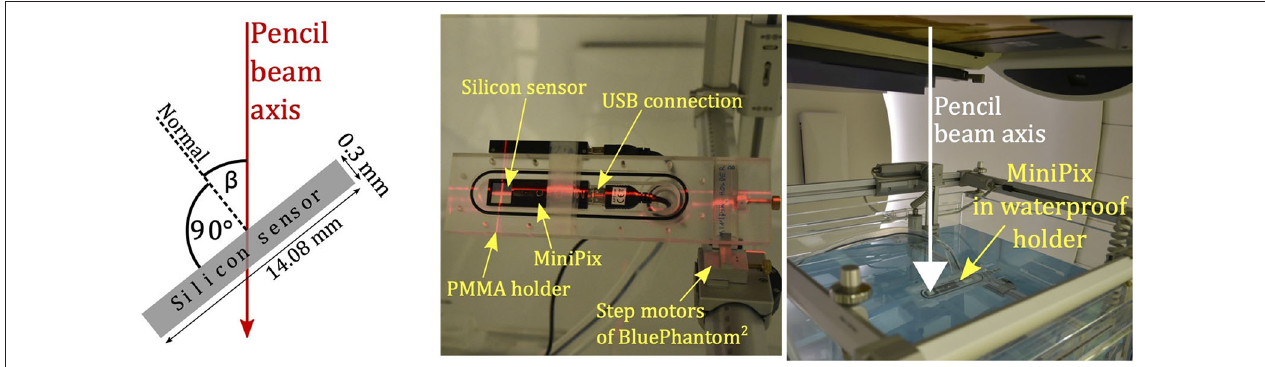
FIGURE 2 | Schematic illustration of M INI P IX T IMEPIX detector silicon sensor and the definition of β angle between the normal to the silicon sensor surface and proton pencil beam axis (left) , M INI P IX T IMEPIX placed in the PMMA holder positioned in water phantom without the waterproof cover (middle) , and immersed in the water phantom filled with water for profile measurements (right)